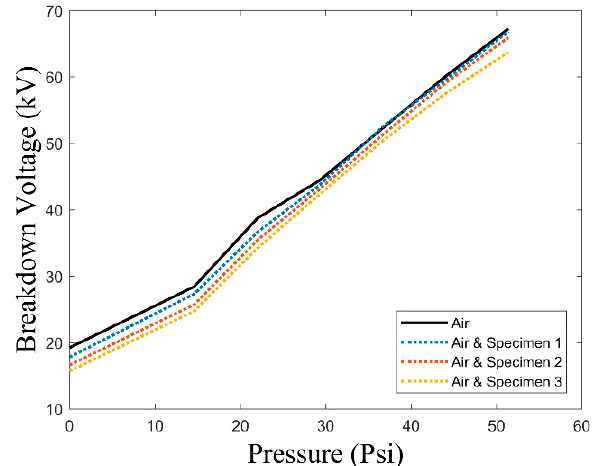
Figure 13. Comparison of disruptive discharge test results regarding air alone and in conjunction with open cell foam specimens of Table 4.